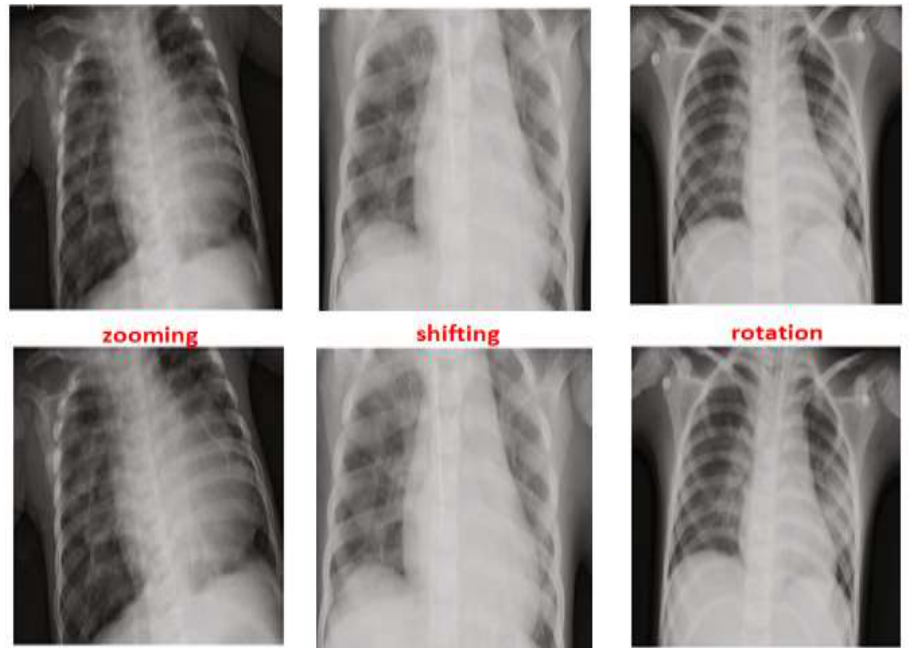
Figure 5. Three cases and their corresponding augmentation methods: zooming, shifting and rotation. Table 1. Data set distribution before and after augmentation and class